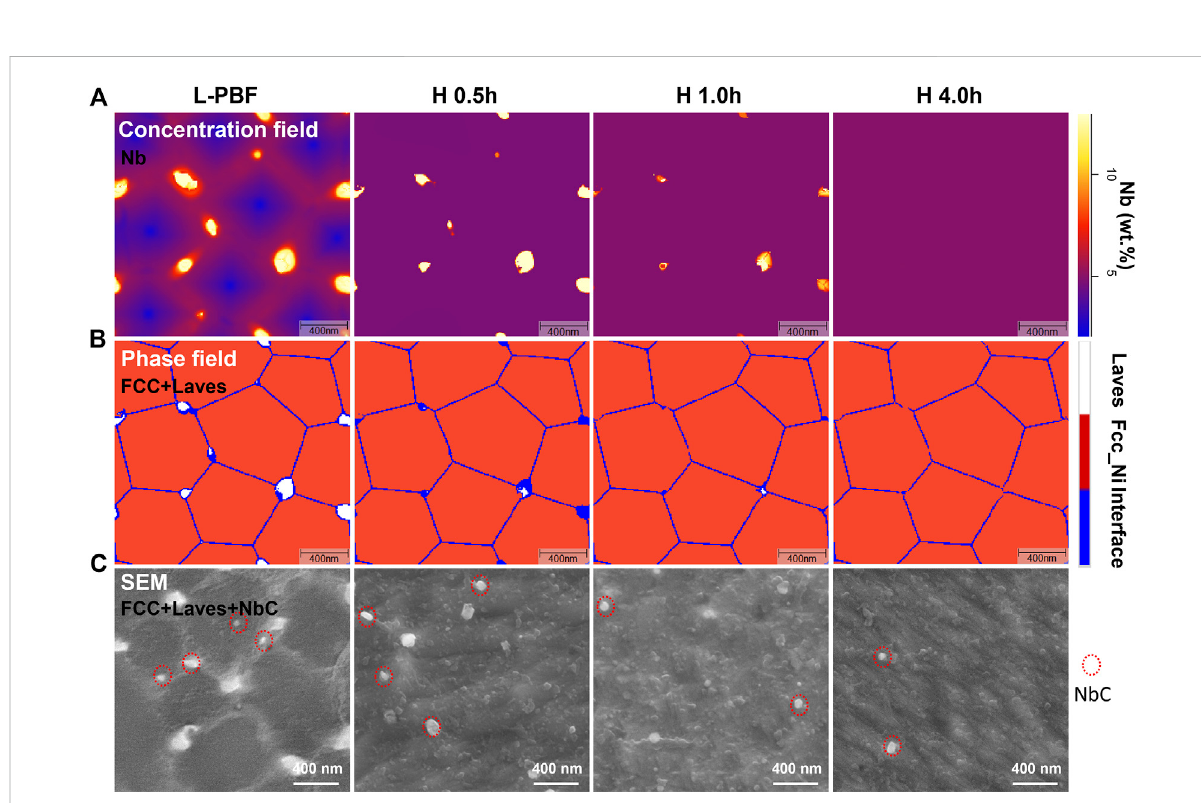
FIGURE 5 (A) Simulated concentration fi elds of Nb, (B) phase fi eld, and (C) SEM images at the homogenization temperature of 1,080 ° C for 0 – 4.0